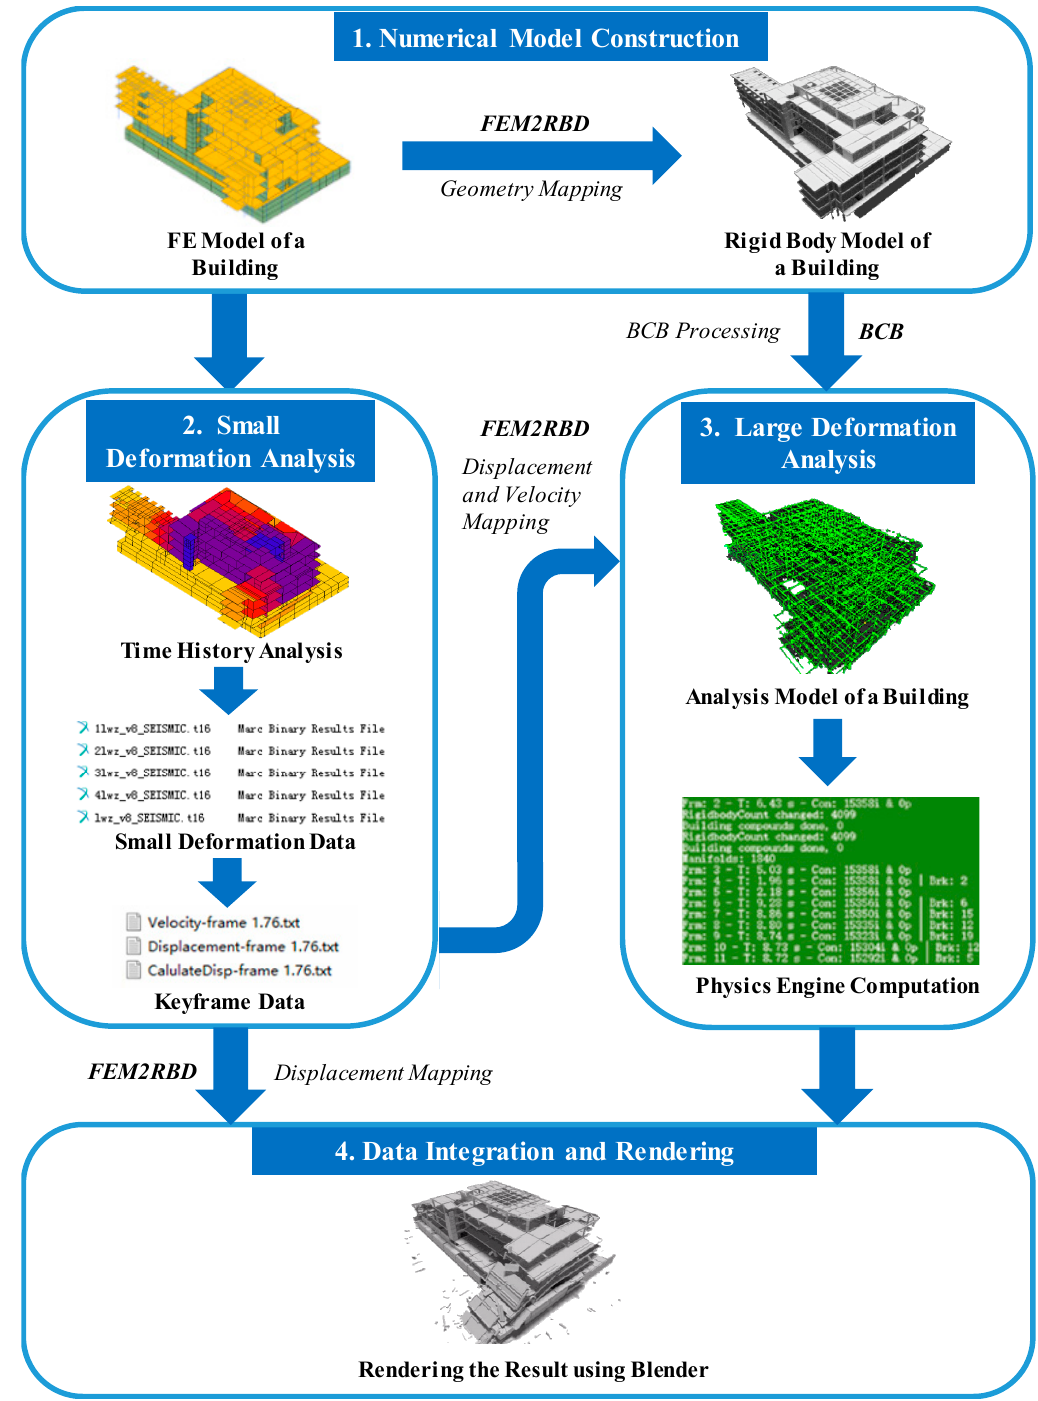
Figure 1. Hybrid framework based on an FE model and a physics engine.